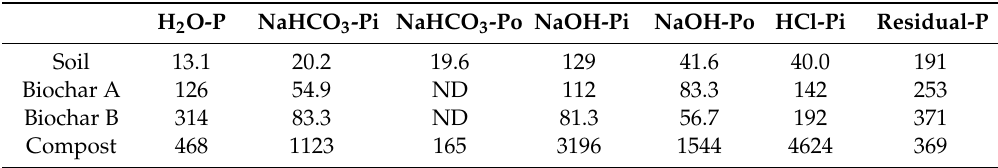
Table 2. Phosphorus contents (mg P kg − 1 ) in di ff erent P fractions in soil and amendments. H 2